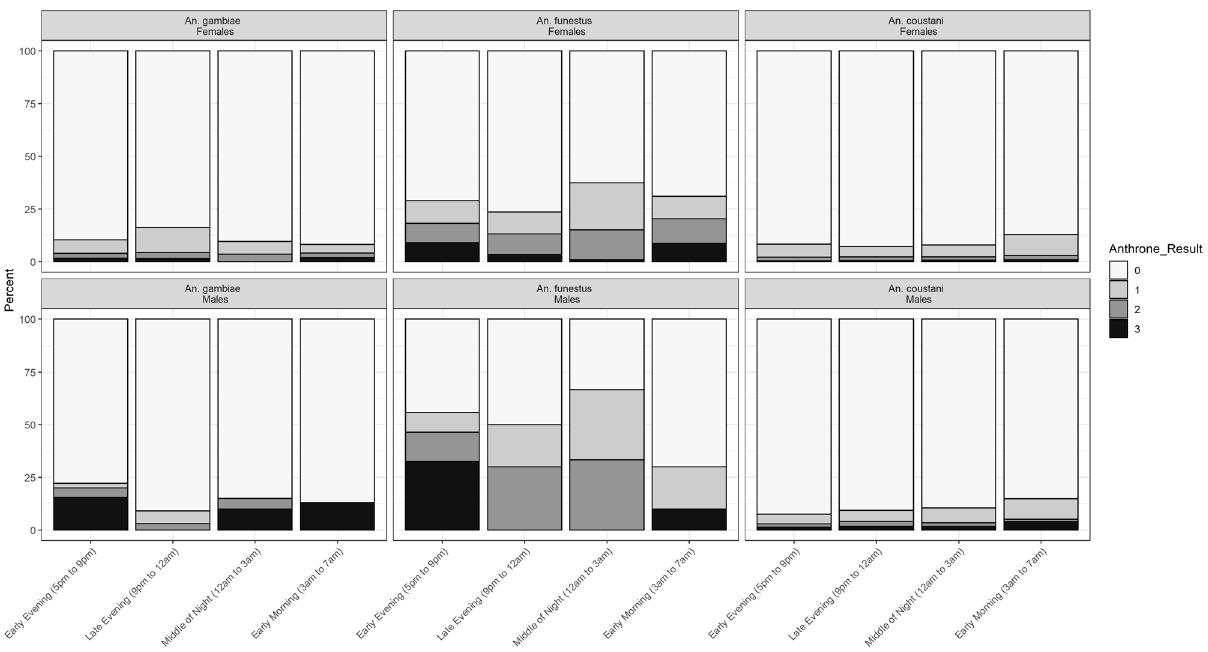
Figure 2. Sugar feeding intensity by the time. Anthrone results (0 = no sugar, 1, 2 and 3 = increasing levels of sugar